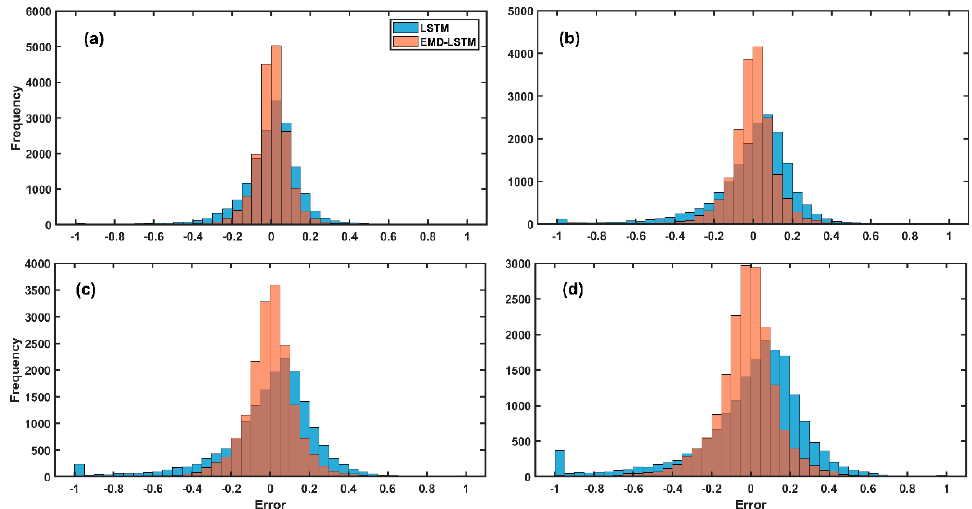
Figure 7. Comparison of LSTM (blue) and EMD-LSTM (red) significant wave height (m) forecast errors at the ( a ) 3, ( b ) 6, ( c ) 9, and ( d ) 12 h windows for buoys 41046 and 41047.